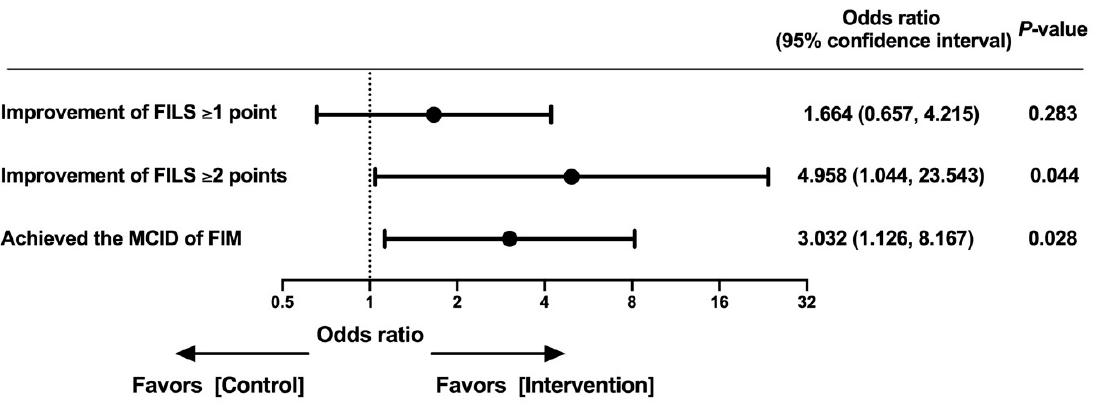
Figure 2. Effect of the mean provided energy on the outcomes at discharge. Effect of the mean provided energy during one week of hospitalization on improvement in swallowing ability at discharge and achievement of the MCID of the FIM. Abbreviations: FILS: Food Intake Level Scale, MCID: minimal clinically important difference, FIM: Functional Independence Measure, IBW: ideal body weight.